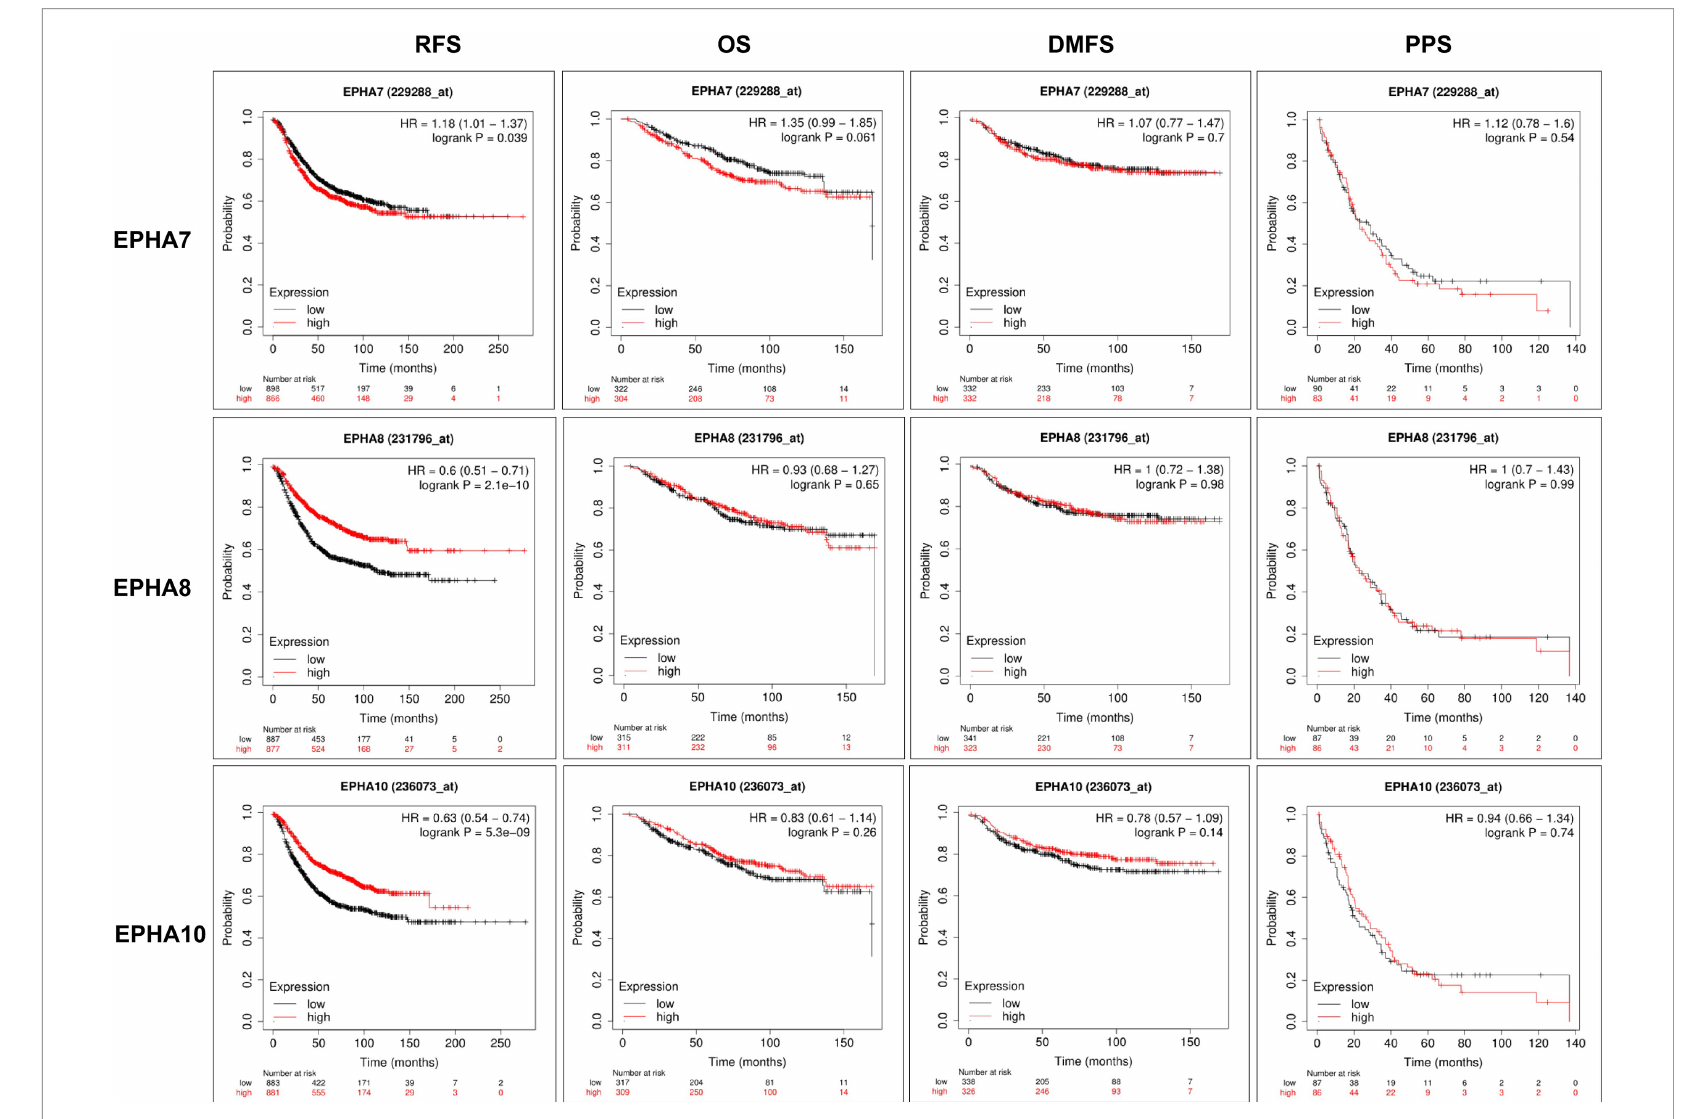
FIGURE 5 | The prognostic signi fi cances of EphA family genes expression in breast cancer patients. The curves generated from the KM plotter database showed the prognostic value of EphA family genes. The assessments include RFS, OS, DMFS, and PPS. The high expression was showed in red curves and the low expression was showed in black curves. The log rank test was displayed at the upper right corner of every